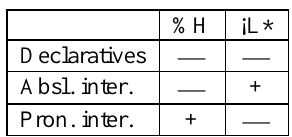
Table 5. Binary distinction of the three utterance types in DS based on an initial boundary tone and upstepping of the nuclear pitch